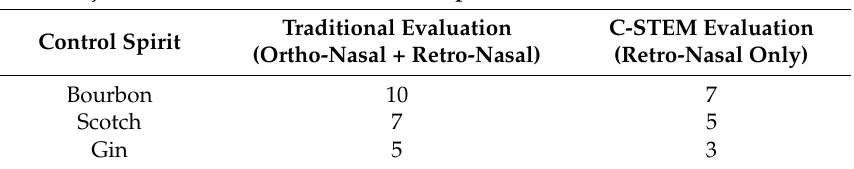
Table 4. Aroma detection comparison. Using a copita vessel, C-STEM evaluations were performed first to eliminate ortho-nasal contributions. Thirty-minute pause, followed by traditional evaluation performed with each control spirit. Testing repeated and verified. Conclusion: Ortho-nasal evaluation may provide a useful benefit to accurate evaluation. Details in Section 2.1 Methods. Subjective Evaluation II: Methods Comparison—Traditional vs.